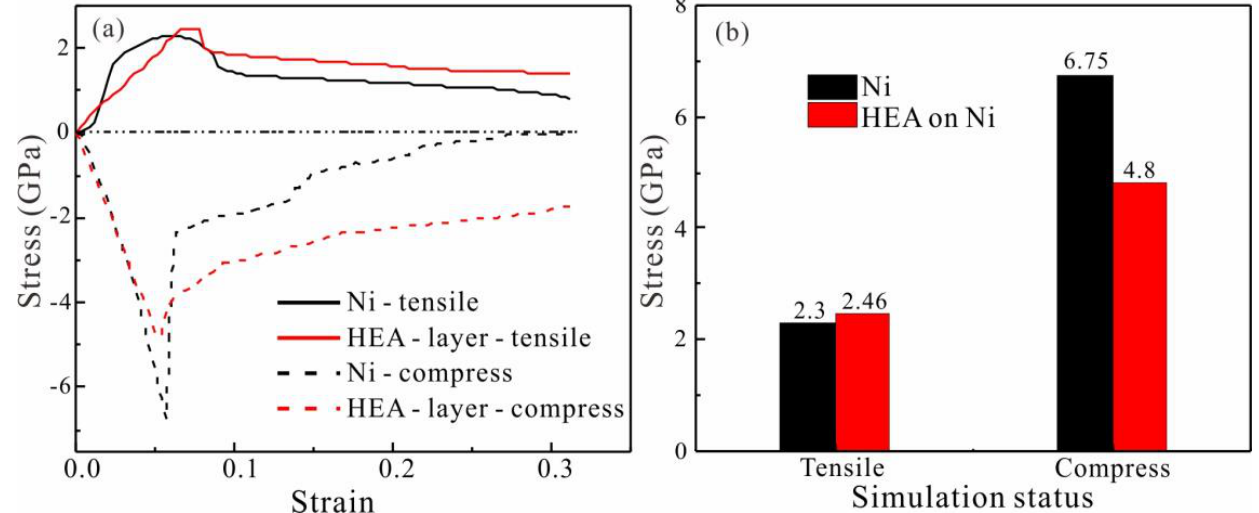
Figure 11. ( a ) Stress-strain curve of pure Ni and Ni reinforced with the HEAs coating at 300 K; ( b ) Histogram of tensile and compressive strength of Fe 33 Ni 32 Cr 11 Co 11 Cu 13 HEA coating and pure Ni. Table 5. Tensile strength, compressive strength and asymmetry ratio of pure Ni and Ni reinforced with the HEAs coating.